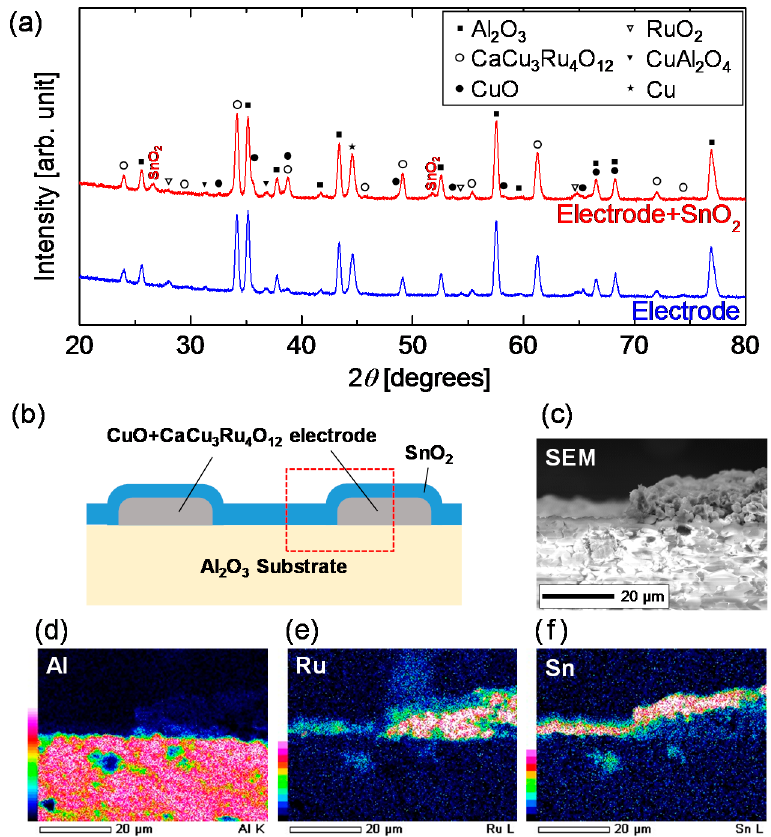
Figure 3. ( a ) XRD (Cu K α ) patterns of the calcined electrode before and after SnO 2 coating; ( b ) Schematic of the cross-section of the electrode side; ( c ) SEM image of the electrode side; ( d – f ) Elemental mapping for Al, Ru, and Sn, respectively.